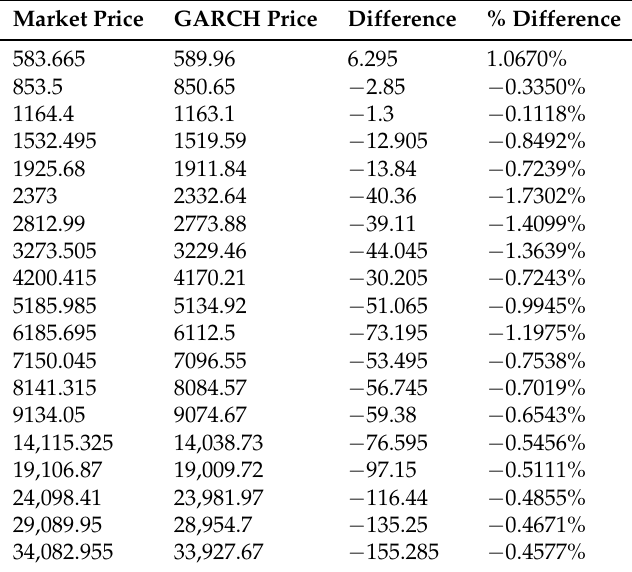
Figure 3. BTCUSD European put option prices. Table 4. BTCUSD European put option prices.